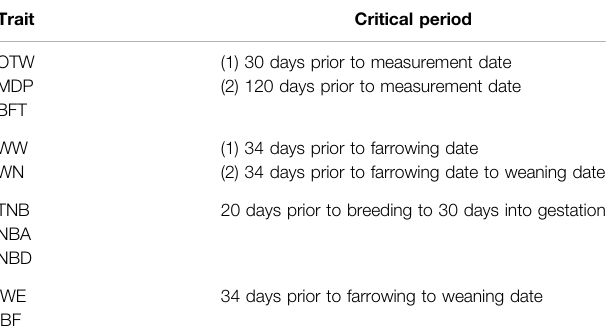
TABLE 1 | Description of the critical periods evaluated for each trait to be used for the genetic and genomic evaluation of heat stress in pigs. Trait Critical